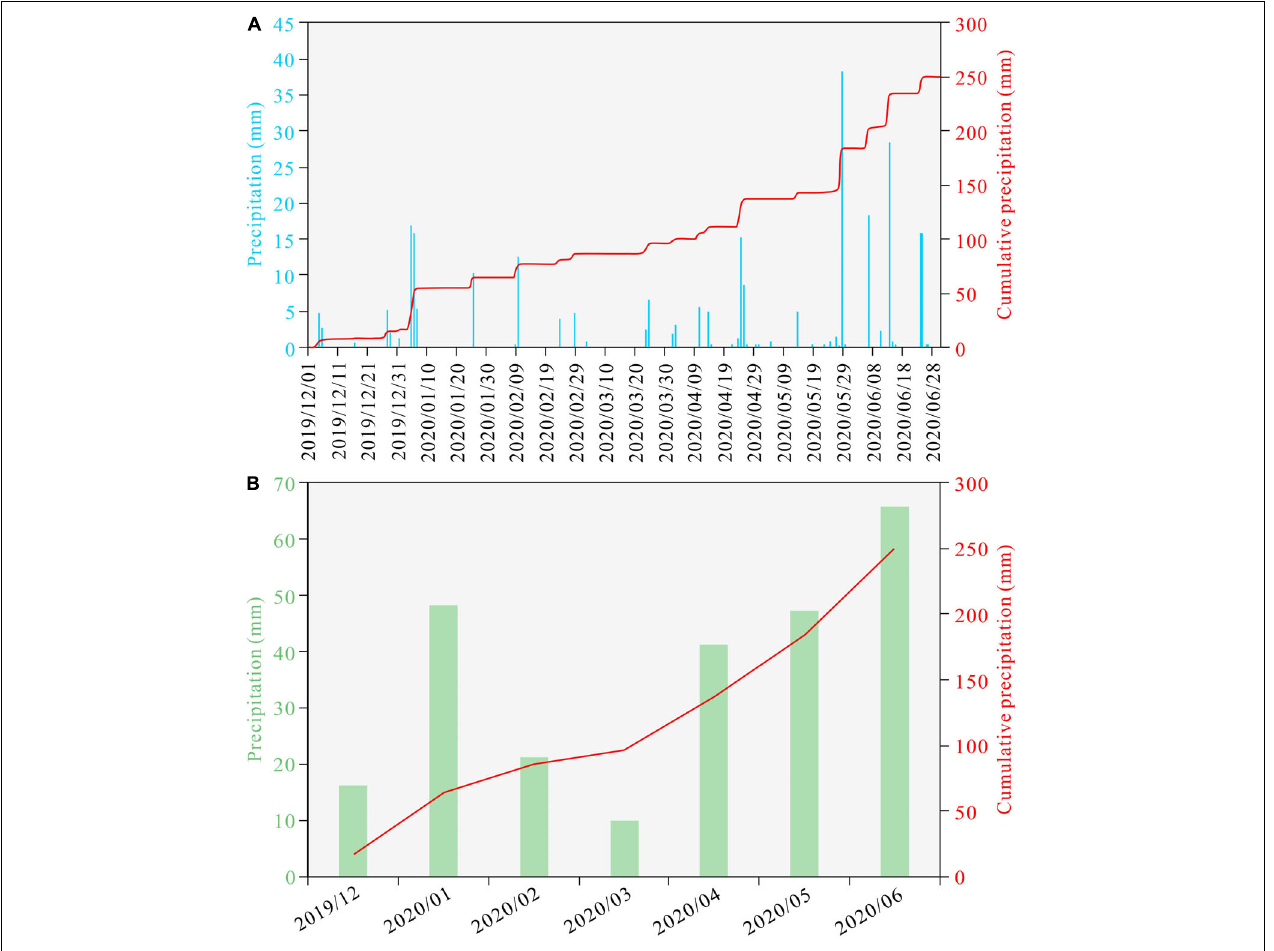
FIGURE 15 | Changes in rainfall in the study area during UAV monitoring. (A) Daily precipitation and cumulative precipitation of study area from December 2019 to June 2020 and (B) Monthly total precipitation and cumulative precipitation from December 2019 to June 2020.